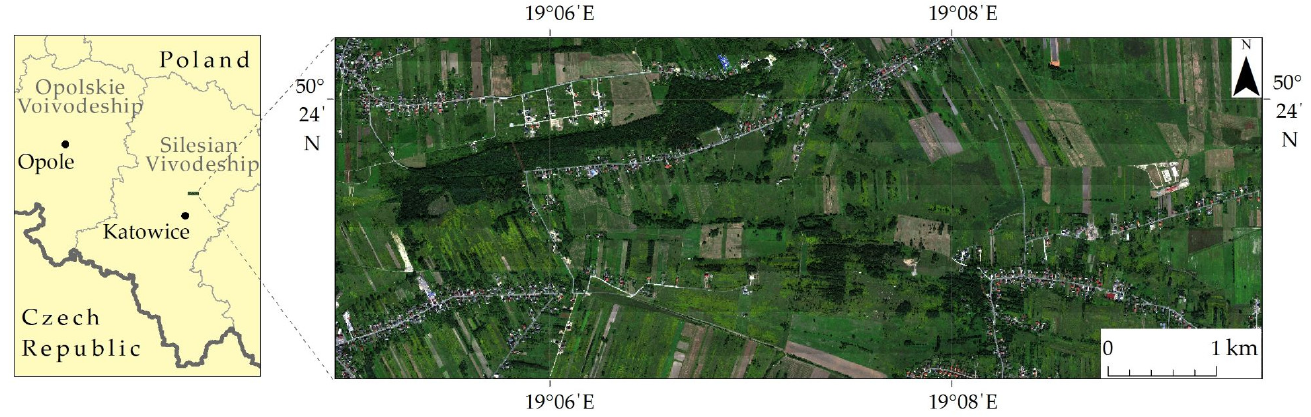
Figure 2. Research area covering flight lines on seminatural agriculturally used fields in Southern Poland.